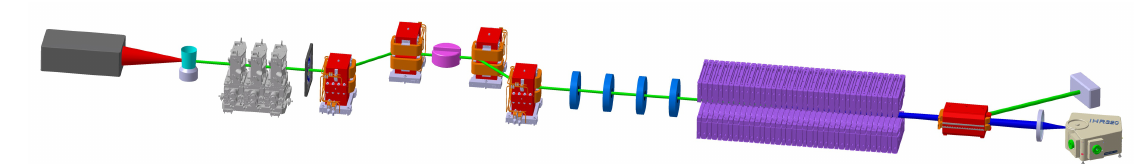
Figure 1. COXINEL beam line starting with the laser hutch (dark grey), gas jet (blue), a triplet of quadrupoles (grey), four dipoles (red), another set of quadrupoles (blue), undulator (purple) and a dipole dump